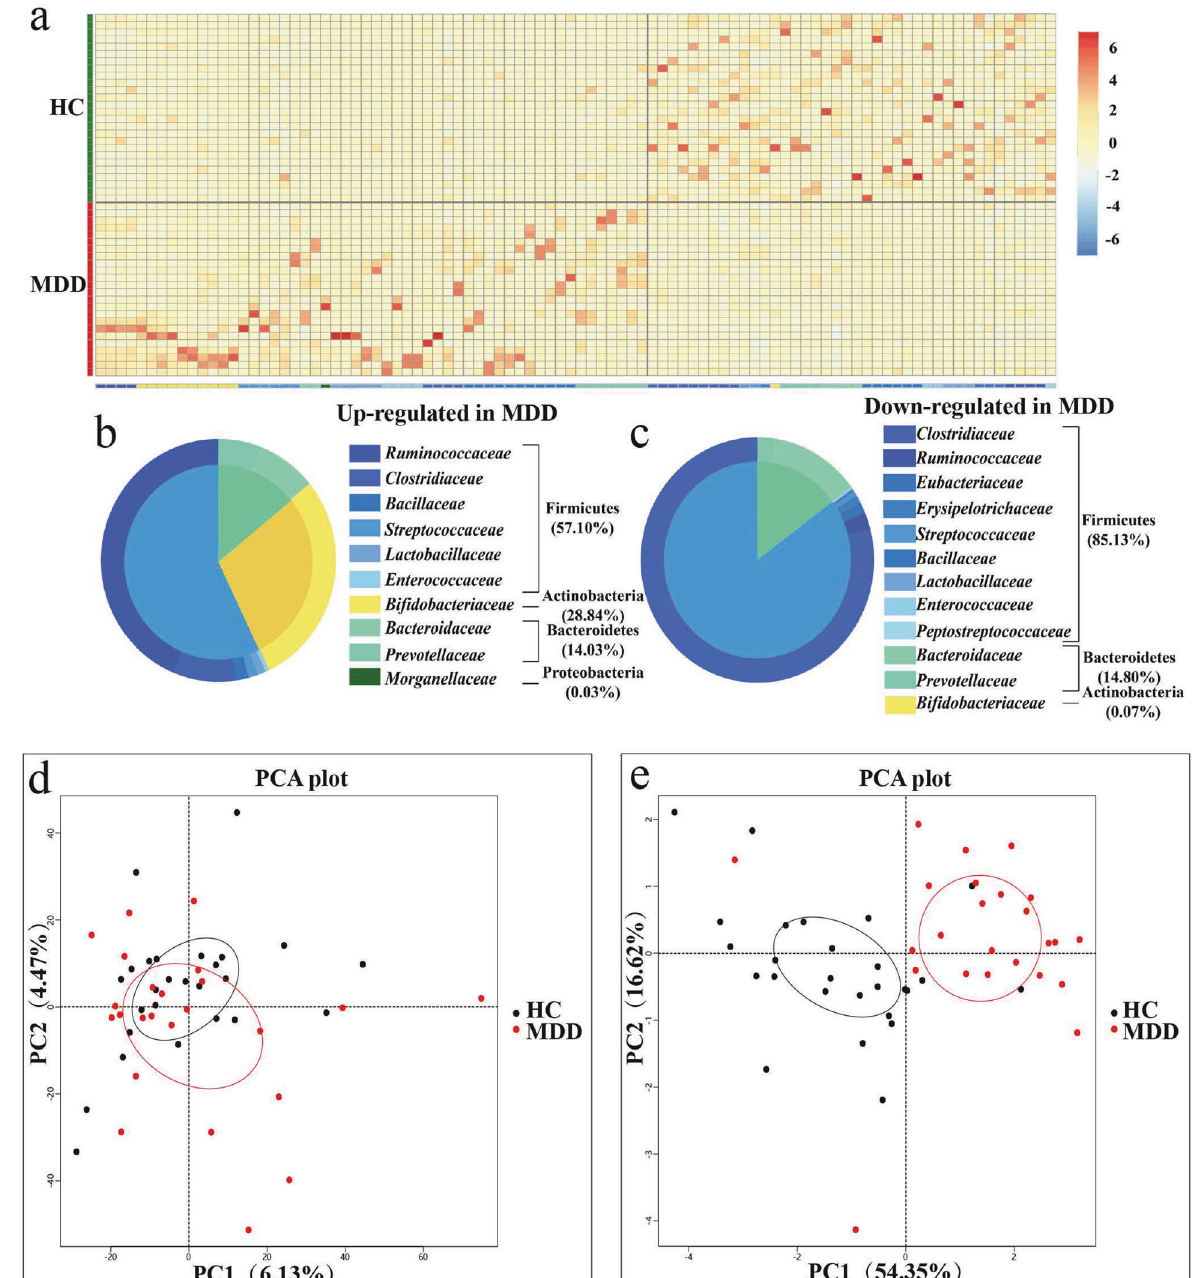
Fig. 1 Alterations of gut microbiota in MDD patients. a – c Using meta-stat analysis, 94 differential species responsible for discriminating the gut microbiota in MDD and HCs subjects were identi fi ed. a Heatmap of the 94 differential species abundances between MDD subjects and HCs. b 54 upregulated species in MDD are arranged on the left, while 40 decreased species are arranged on the right. c Most of the upregulated species belong to Firmicutes (57.10%), Actinobacteria (28.84%), and Bacteroidetes (14.03%), while downregulated species mainly belong to Firmicutes (85.13%) and Bacteroidetes (14.80%). d Principal component analysis (PCA) showed that gut microbial composition of MDD patients was signi fi cantly different from that in HCs at the species level. ( n = 24, MDD group; n = 26, HC group). e Principal component analysis (PCA) revealed the differences in microbial functions between the MDD patients and HCs on KEGG level 3. the MDD group (Fig. 3(b)). The top six metabolites by P-value are Metabolites showing a signi fi cant difference between MDD taurine, nicotinamide (NAM), 3 ’ -aenylic acid, phosphoethanolamine and HCs (PEA), adenosine 5 ’ -monophosphate, and dl-dihydrosphingosine. Metabolites from MDD and HCs were used for partial least According to HMDB classi fi cation, 29 increased metabolites mainly squares discriminant analysis (PLS-DA), which showed distinct belong to lipids and lipid-like molecules (7/29, 24.14%), nucleotide separation between two groups (Fig. 3(a)). It suggests that MDD and its derivates (5/29, 17.24%), vitamins (3/29, 10.34%), organic patients have a dissimilar metabolic mode relative to HCs. acids and derivatives (3/29, 10.34%) (Fig. 3(d)). In addition, amino Compared to the HC group, a total of 34 signi fi cantly different acid and its derivatives (3/5, 60.00%), lipids and lipid-like molecules metabolites were identi fi ed, with 29 increased and 5 decreased in Translational Psychiatry (2022)